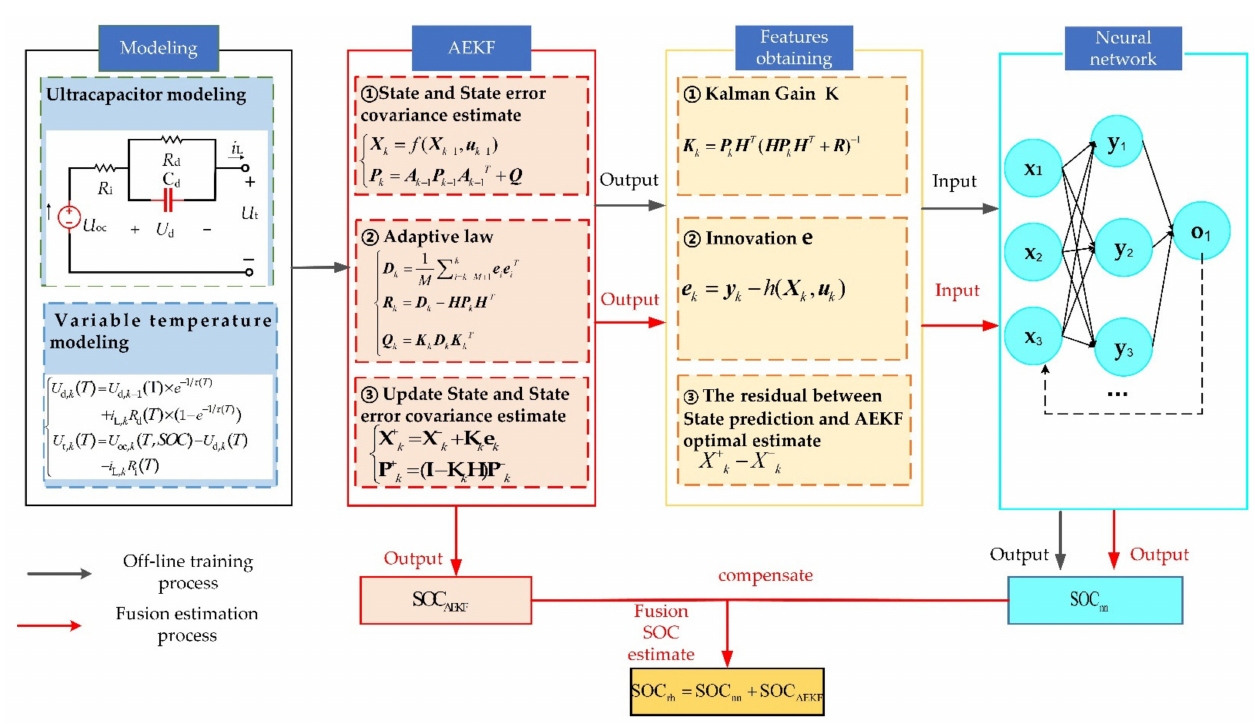
Figure 5. An implementation flowchart of the SOC fusion estimation method.